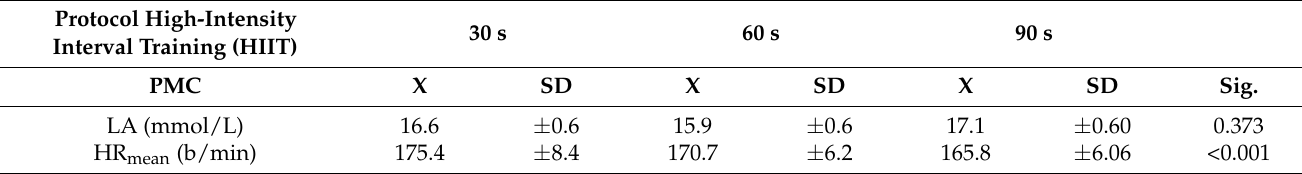
Table 1. Physiological control parameters chosen at the baseline for the 3 different training protocols. Protocol High-Intensity